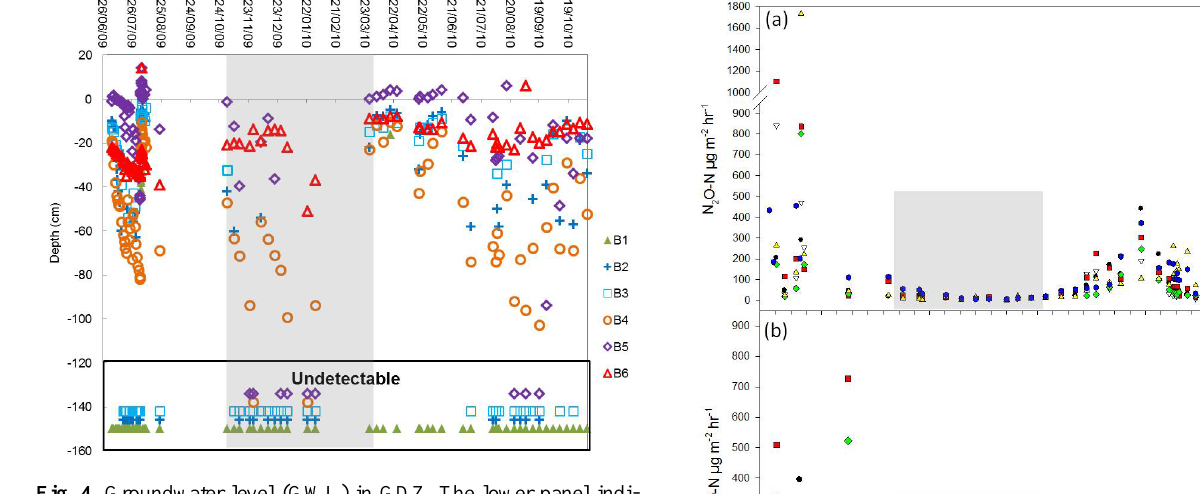
Fig. 4. Groundwater level (GWL) in GDZ. The lower panel indi- cates plots and dates at which the groundwater level was below the bottom of the monitoring well. Shaded area indicates the dry-cool season.